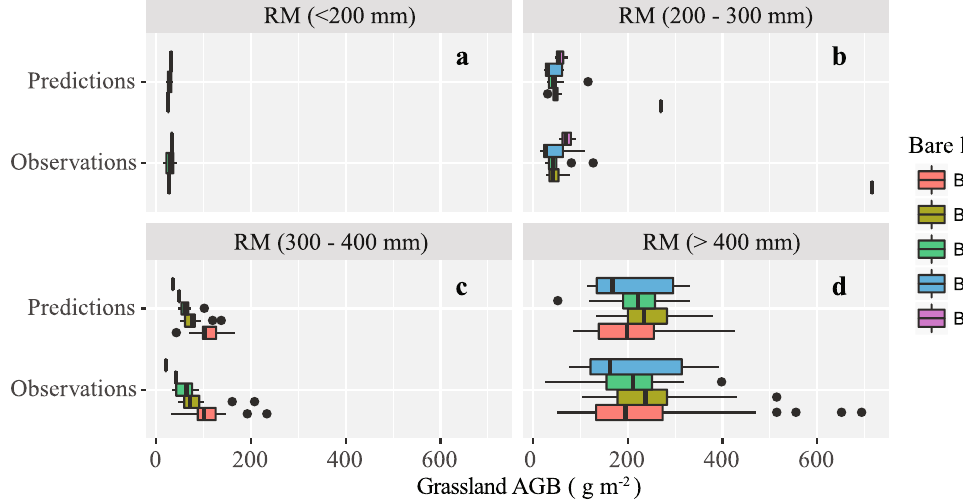
Figure 2. Observed and predicted grassland AGB in several of rainfall gradients (RM was annual average rainfall of 2011, 2012 and 2013) and bare land percentages (The total = 100%. B1: < 20%; B2: 20–40%; B3: 40–60%; B4: 60–80%; B5: >